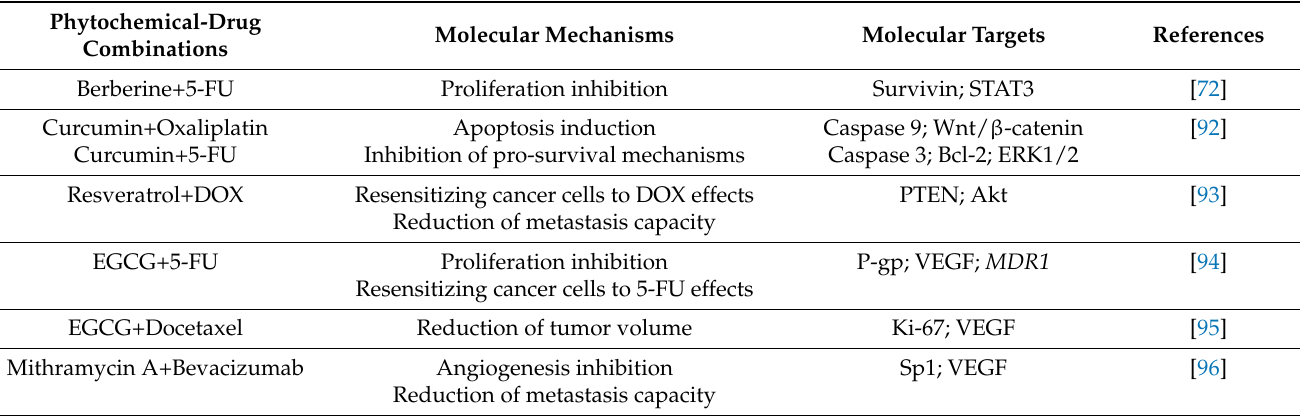
Table 2. Gastric cancer